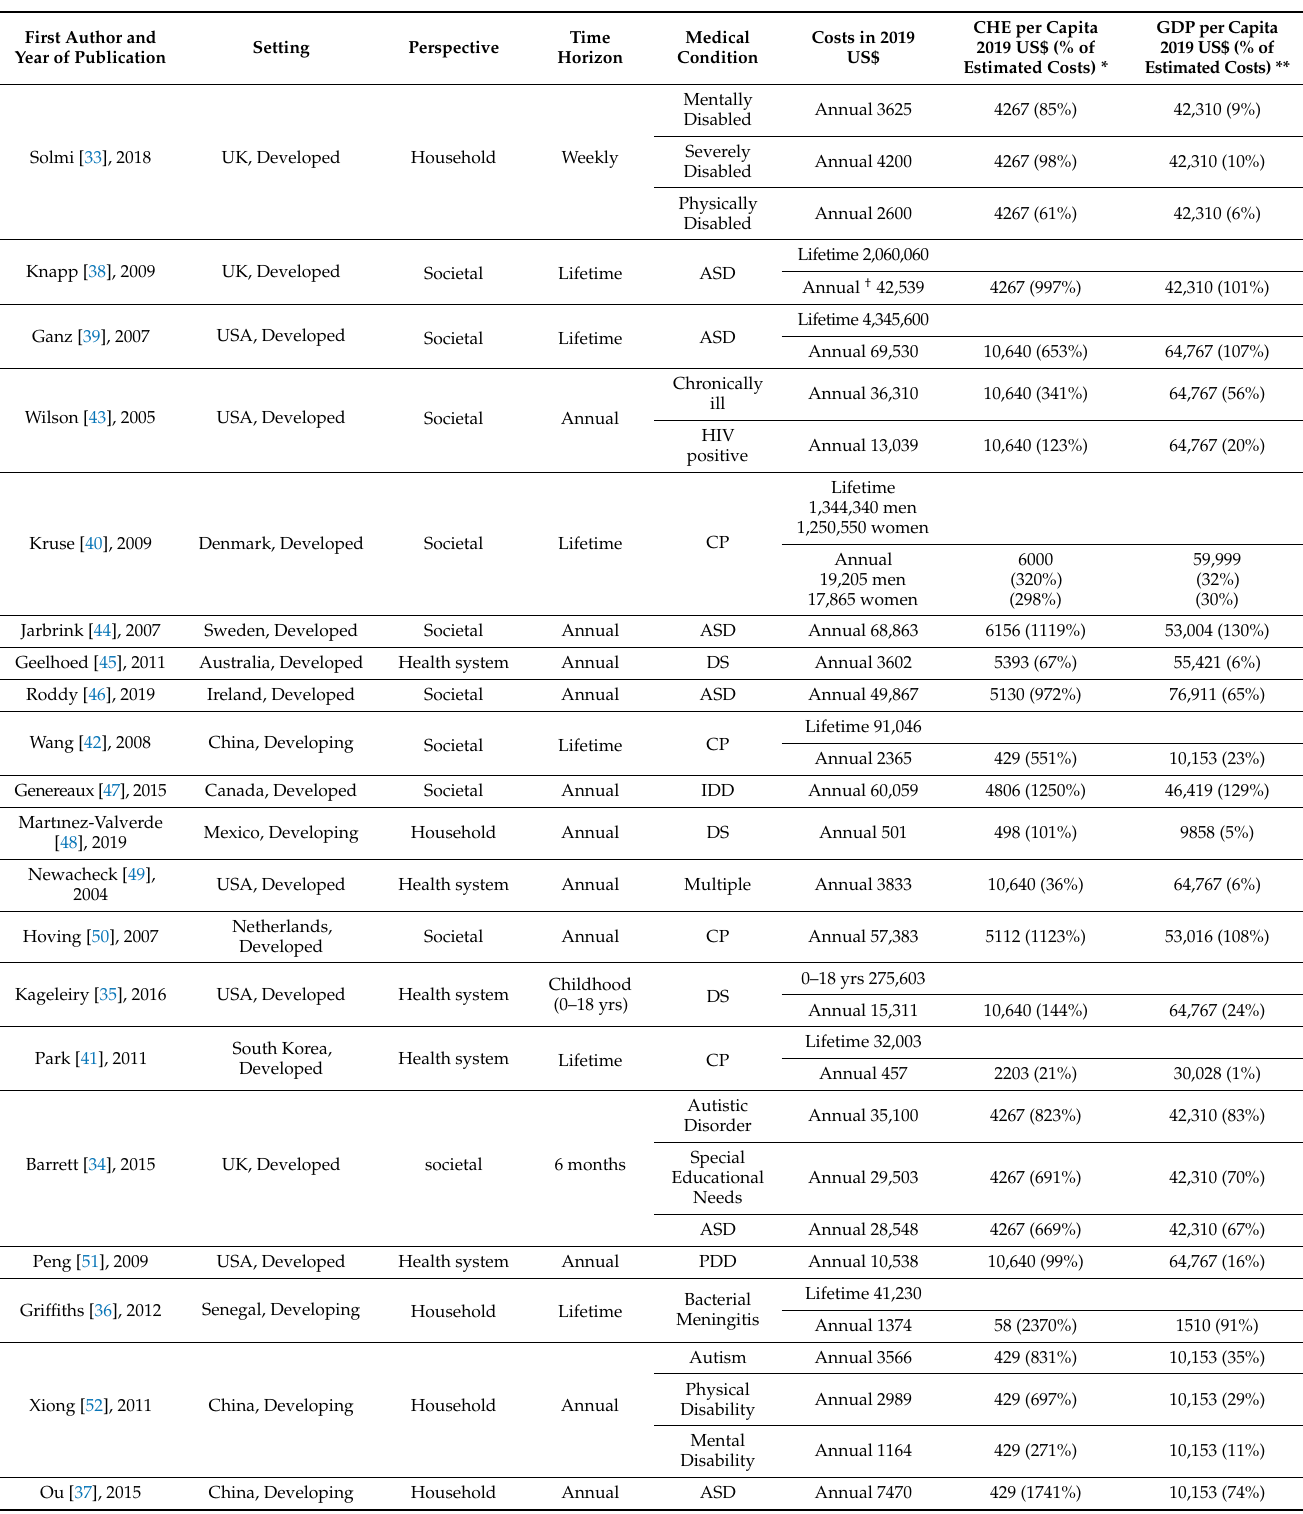
Table 1. Results of the literature review on costs of childhood